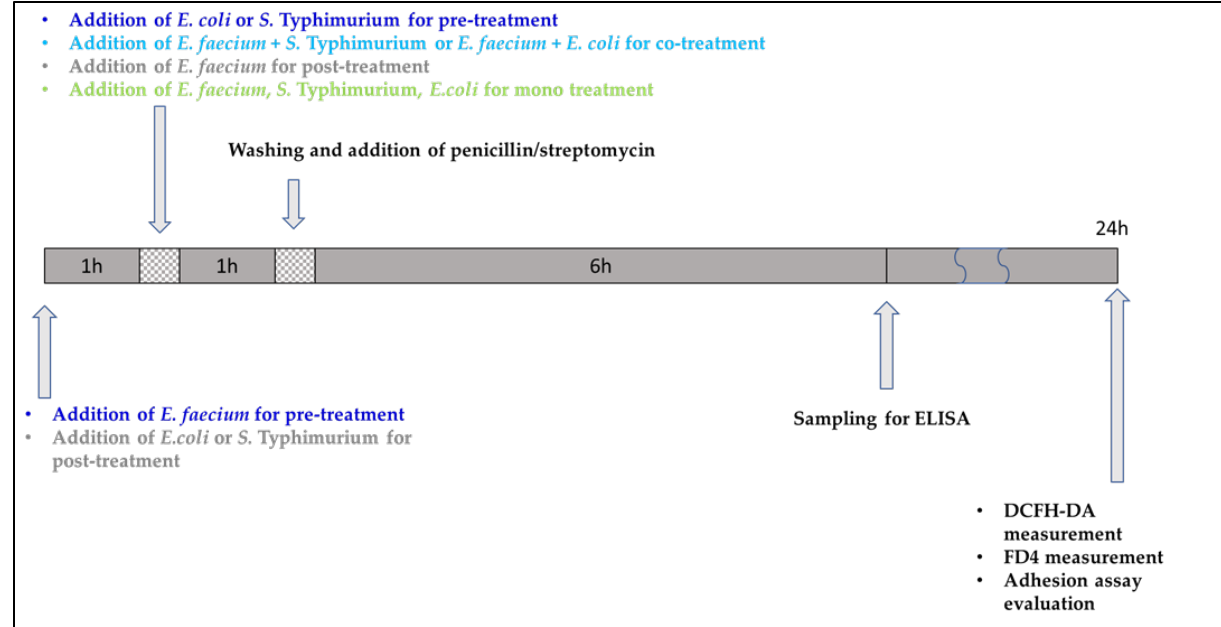
Figure 1. Timeline for experimental setup.